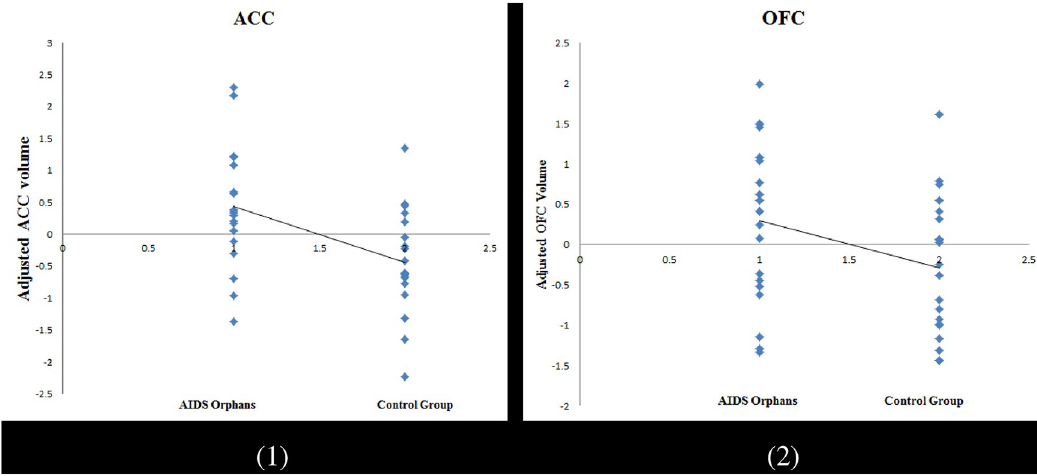
Fig 1. Gray matter volume in sub-regions of PFC, which demonstrating a significant difference between AIDS orphans and normal adolescents (controlled for age, gender, and whole brain gray matter volume, (1) = ACC; (2) = OFC).